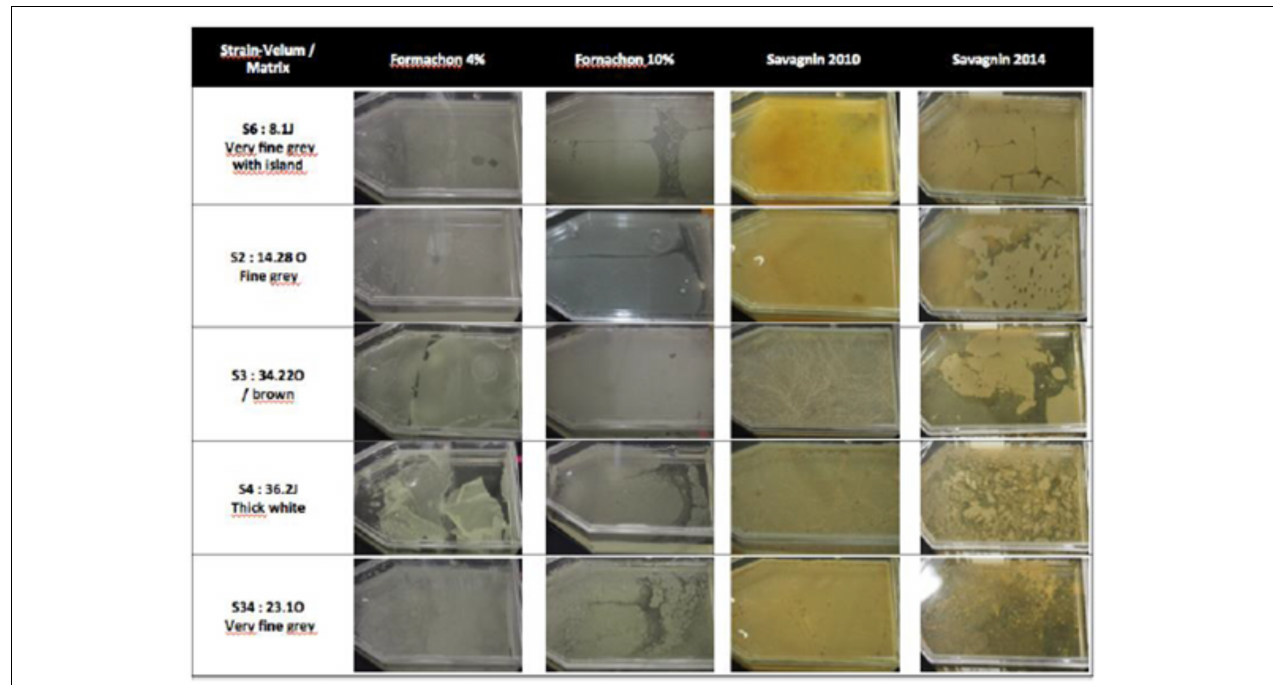
FIGURE 4 | Structure and color of velum on different matrixes: grape, juice medium (Fornachon, 1953), synthetic [Fornachon 4% and 10% (v/v) ethanol] and two Savagnin wines (vintage 2010 and 2014) observed after 1 month. The inoculated strains are from different velums: S6: strain 8.1J from very fine gray velum with islands; S2: 14.2O strain from fine gray velum; S3: 32.22O from brown velum; S4: 36.2J strain from thick white velum and S34: 23.1O strain from very fine gray